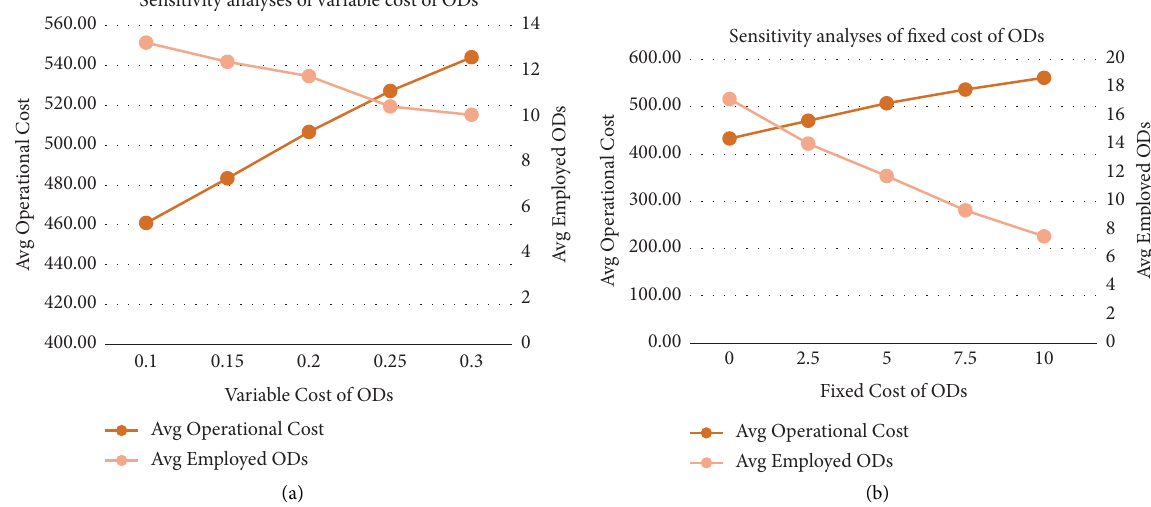
Figure 3: Sensitivity analyses of the cost of ODs. (a) Sensitivity analyses of the variable cost of ODs. (b) Sensitivity analyses of the fxed cost of ODs.